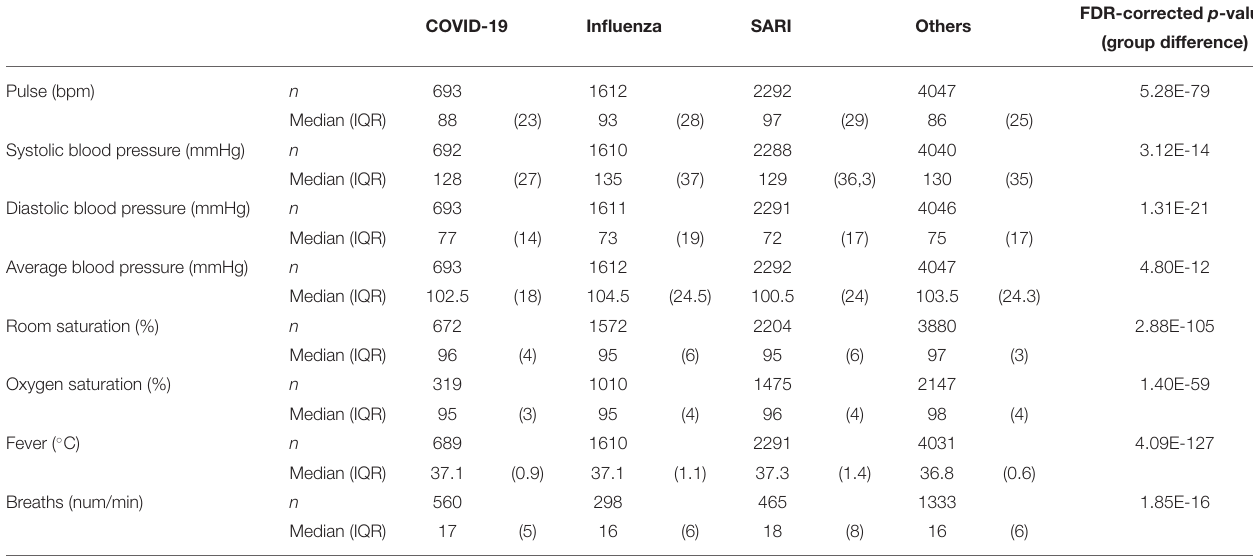
TABLE 3 | Vital signs at admission.